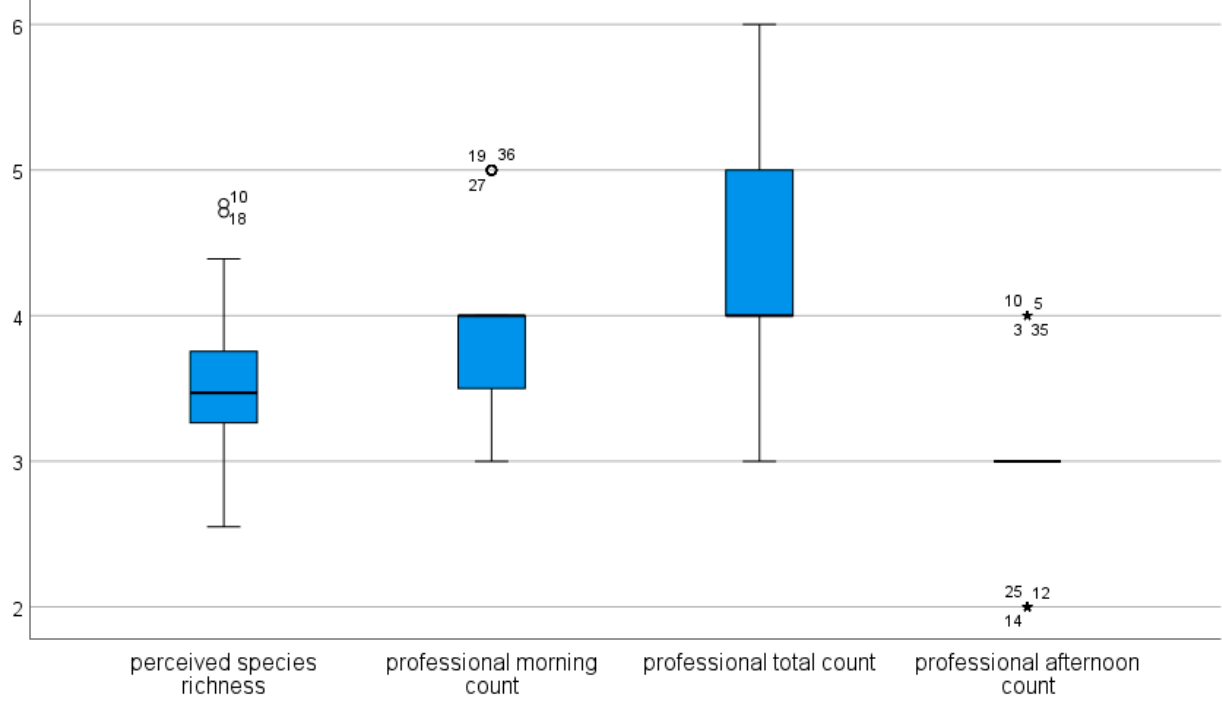
Figure 1. Perceived species richness of laypeople (measured in categories, averaged per place) cor- related with the professional total count (measured in absolute numbers).